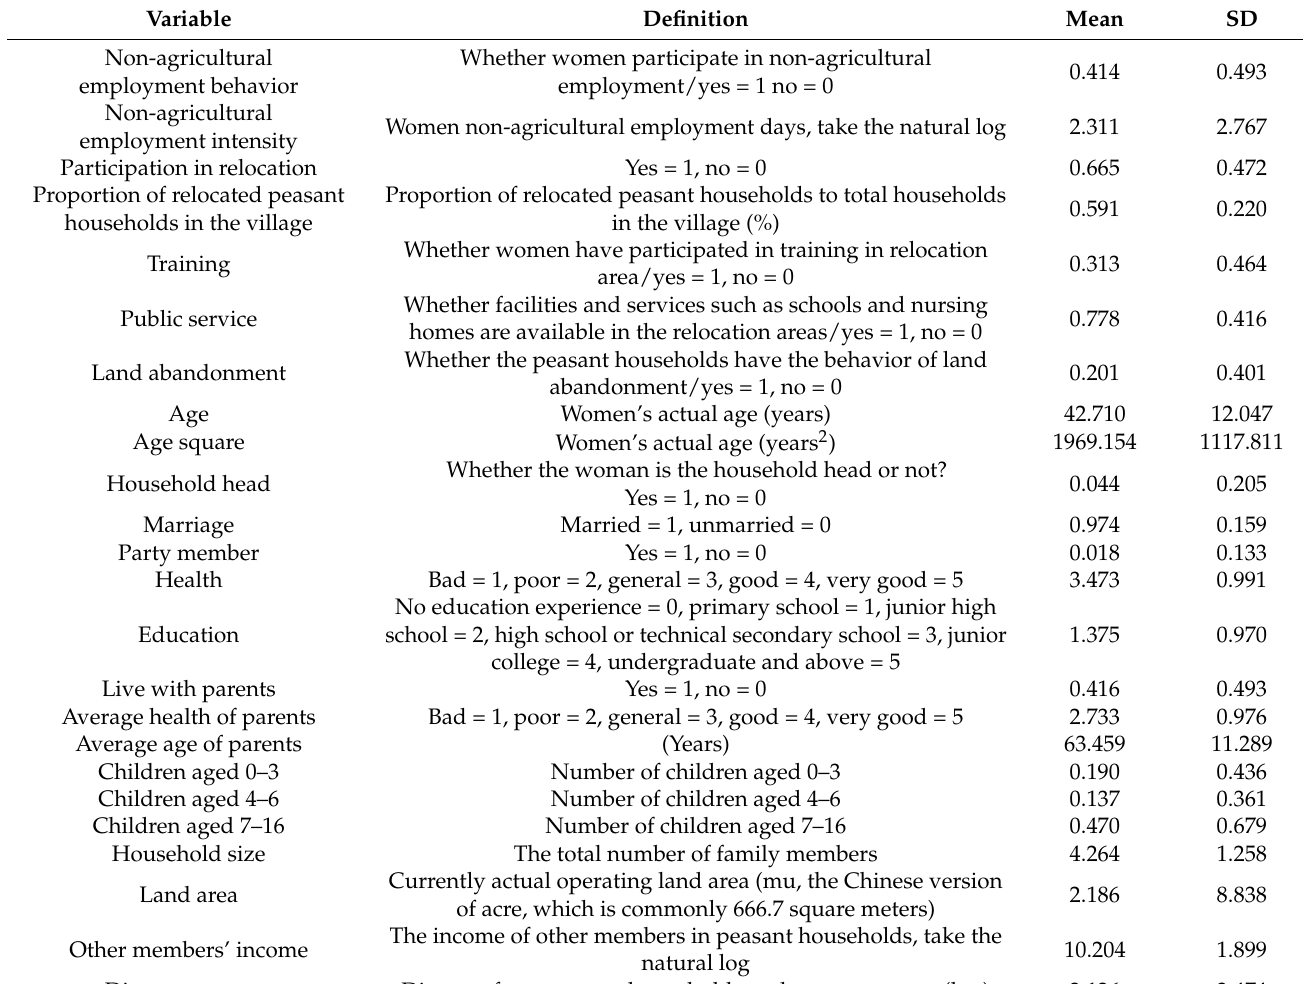
Table 1. Variable definitions and descriptive